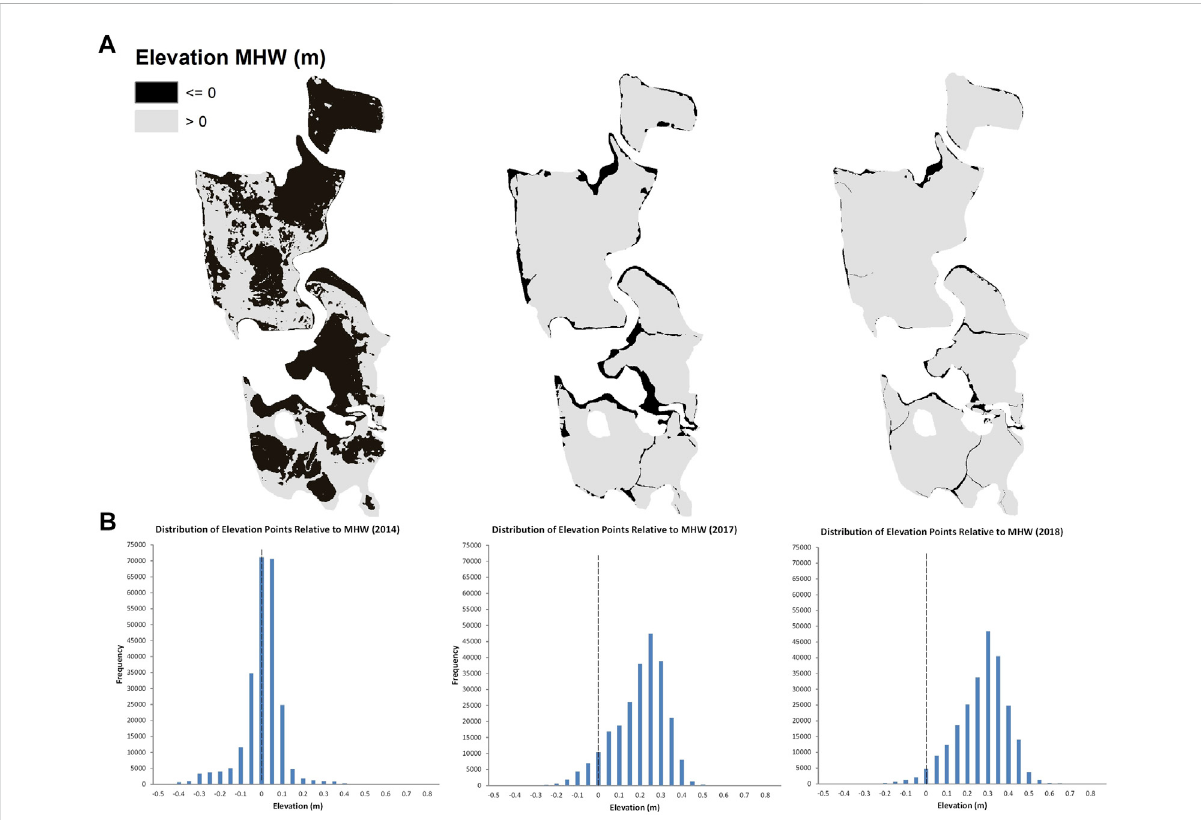
FIGURE 3 Whole-marshscalechangesinelevation (A) andfrequencydistributionsofelevationpointsfrom fi eldsurveys (B) attheNinigretimpactsiteover time.Lefttoright:2014 =pre-sedimentplacementconditionswhenoverhalfthemarsh areawasatelevationsbelowMHW;2017=the fi rstgrowing season after sediment placement when elevation was greatly increased by new sand; 2018 = the second growing season after sediment placement when elevation above MHW again increased